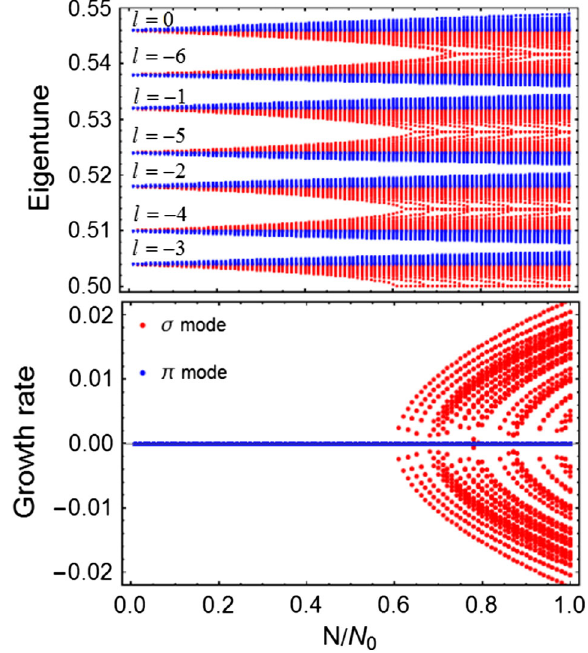
FIG. 8. Eigenvalues of σ and π modes as a function of bunch population without longitudinal impedance, where ν The red and blue points represent the σ and π modes,